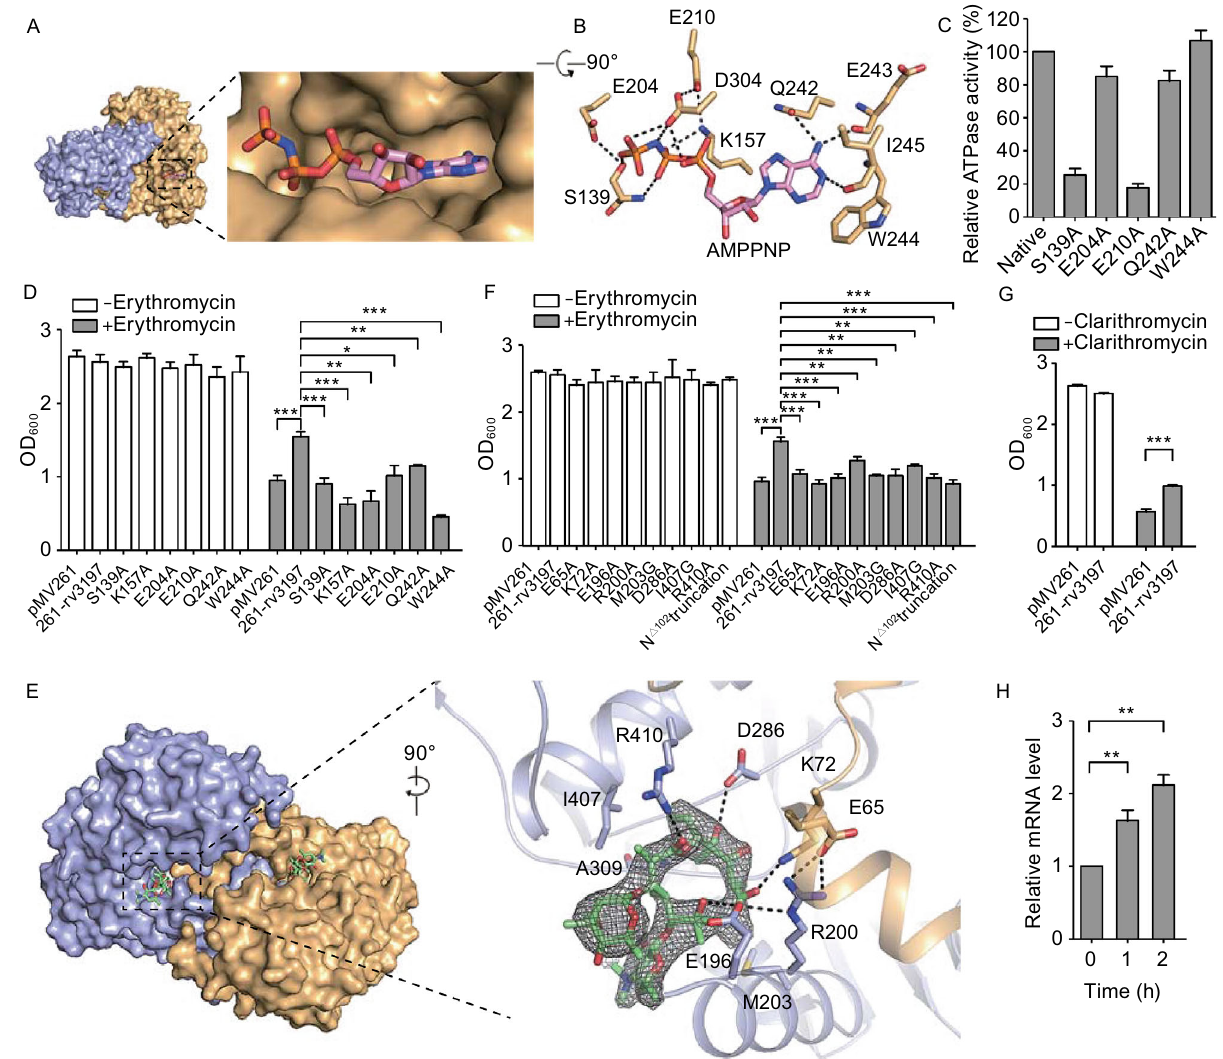
Figure 2. MABP-1 is an ATPase and the accessory domain of MABP-1 is vital for erythromycin binding and dimerization . (A) Structure of the MABP-1 ⋅ AMPNP complex. MABP-1 is shown as a surface representation with AMPPNP as a stick model. Each subunit is coloured light orange and light blue. (B) The nucleotide-binding site in MABP-1. Hydrogen bonds are shown as dashed lines. (C) Relative ATPase activity of MABP-1 mutants in the nucleotide binding site (mean ± SD of three individual experiments). (D) The growth of mc 2 155 wild type and mutant strains in the presence (+) or absence ( − ) of 6.25 mg/L erythromycin (mean ± SD of three individual experiments, * P < 0.05, ** P < 0.01, *** P < 0.001). (E) Left, surface representation of the erythromycin binding site. Erythromycin has green carbon atoms. Right, the F o − F c omit map for erythromycin, contoured at 3.0 σ . Residues that interact with erythromycin are shown as stick models. Hydrogen bonds are shown as dashed lines. (F) The growth of mc 2 155 wild type and mutant strains in the presence (+) or absence ( − ) of 6.25 mg/L erythromycin. (G) The growth of pMV261-mc 2 155 and pMV261- rv3197 - mc 2 155 in 7H9 medium with (+) or without ( − ) 0.75 mg/L clarithromycin. (H) Quanti fi cation of mRNA levels of rv3197 in BCG by qRT- PCR at the indicated time points after treatment with 1.5 mg/L clarithromycin (mean ± SD of three individual experiments, * P < 0.05, ** P < 0.01, *** P <